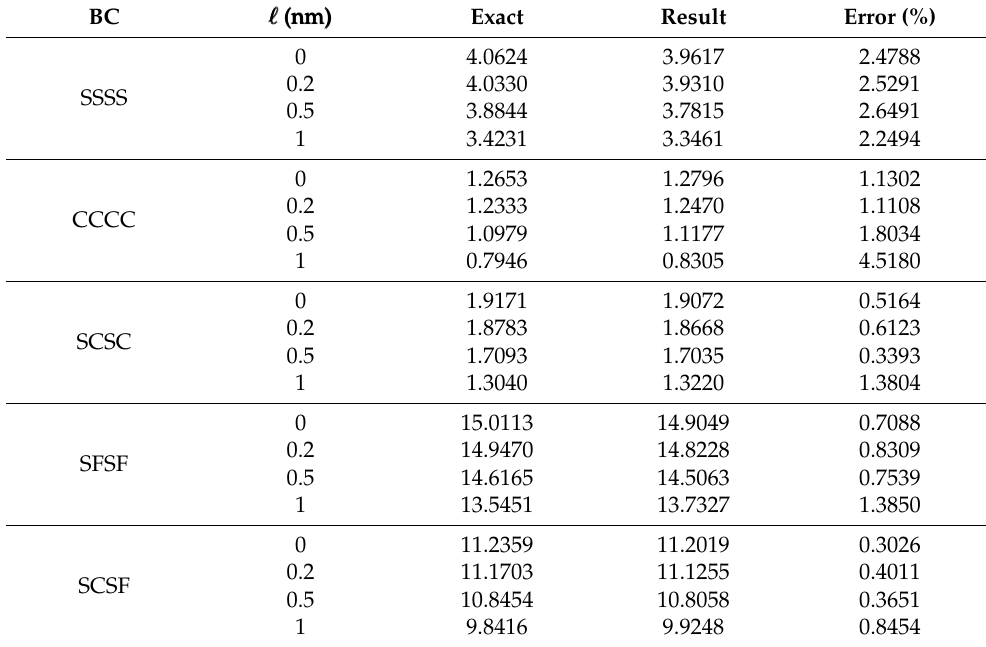
Table 5. Values of ¯ w for 7 × 7 nodal distribution, obtained for α C = 1.06, q = 1.3, α s = 3.